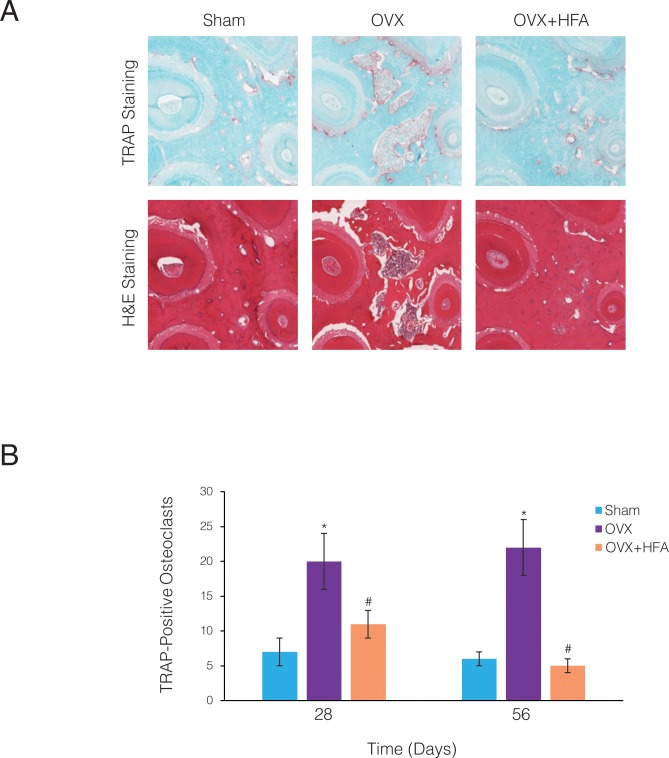
HFA reduced osteoclast numbers in alveolar bone.(A) Light microphotographs of H&E and immunohistochemically stained sections for TRAcP-5b. Images were collected close to the mid-root area of the first maxillary molar after 56 days of HFA application. Osteoclasts are identified as TRAcP-5b red cells in sections from different experimental groups. (B) Mean number of osteoclasts present in 5 consecutive sections of the ROI of the maxillary first molar. Each value represents the mean ± SEM of 6 animals (* Significantly different from Sham group; # significantly different from OVX group).